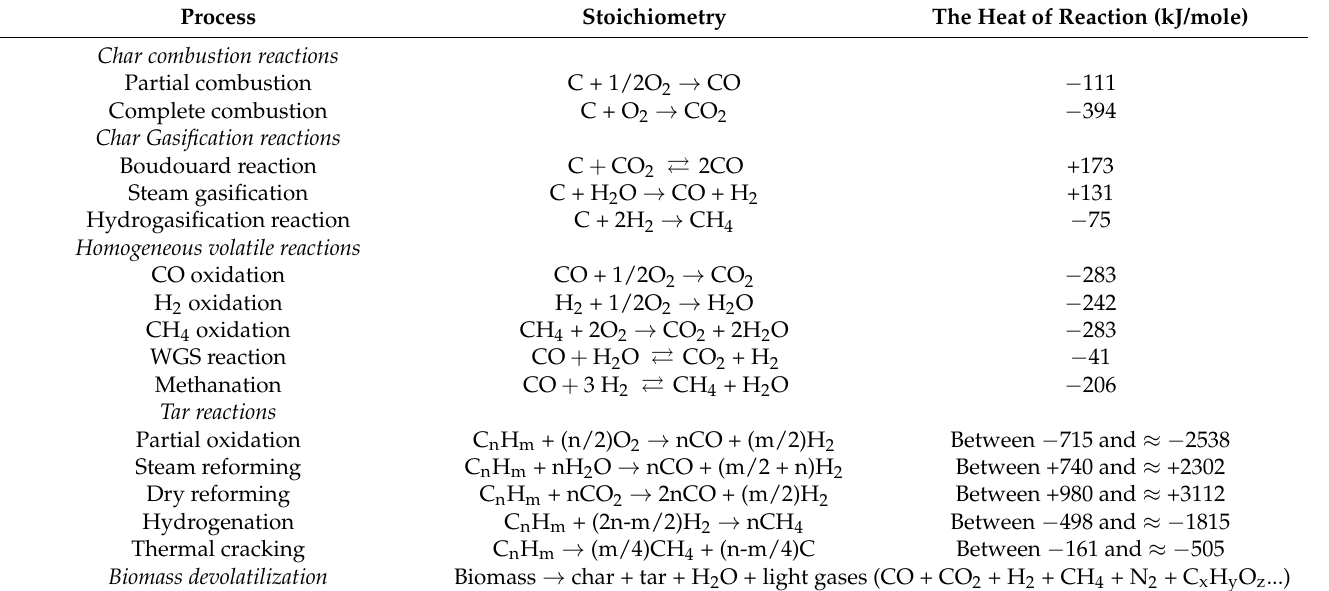
Table 1. Main reactions in biomass gasification processes adapted with permission from [20], biomass and bioenergy; published by Elsevier,